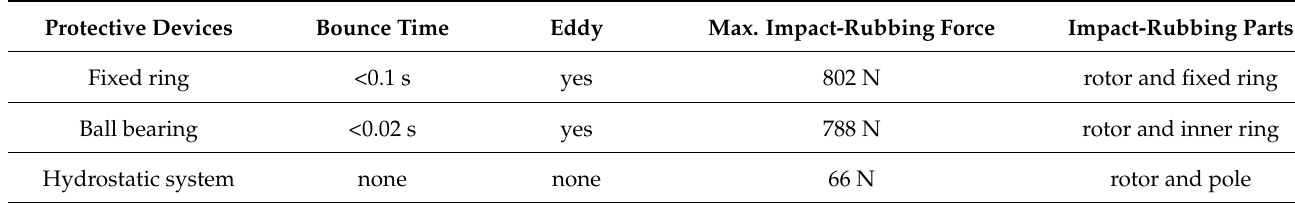
Table 3. Influence of upper and lower unit failure on